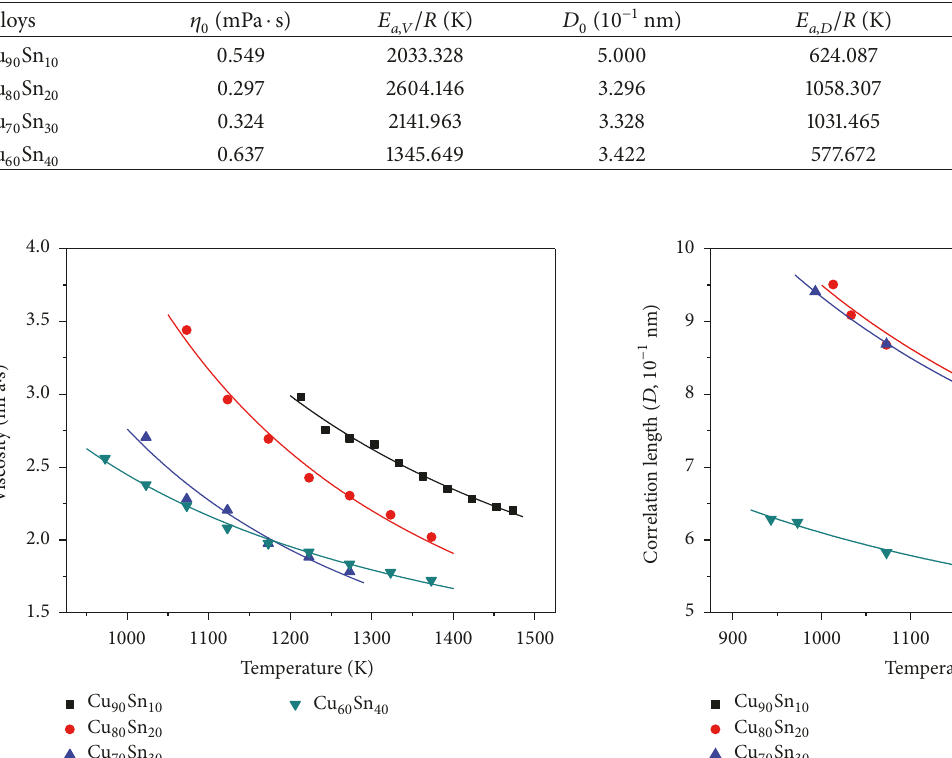
Figure 2: Temperature dependence of correlation length of Cu-Sn alloys (the lines are fitted by the Arrhenius